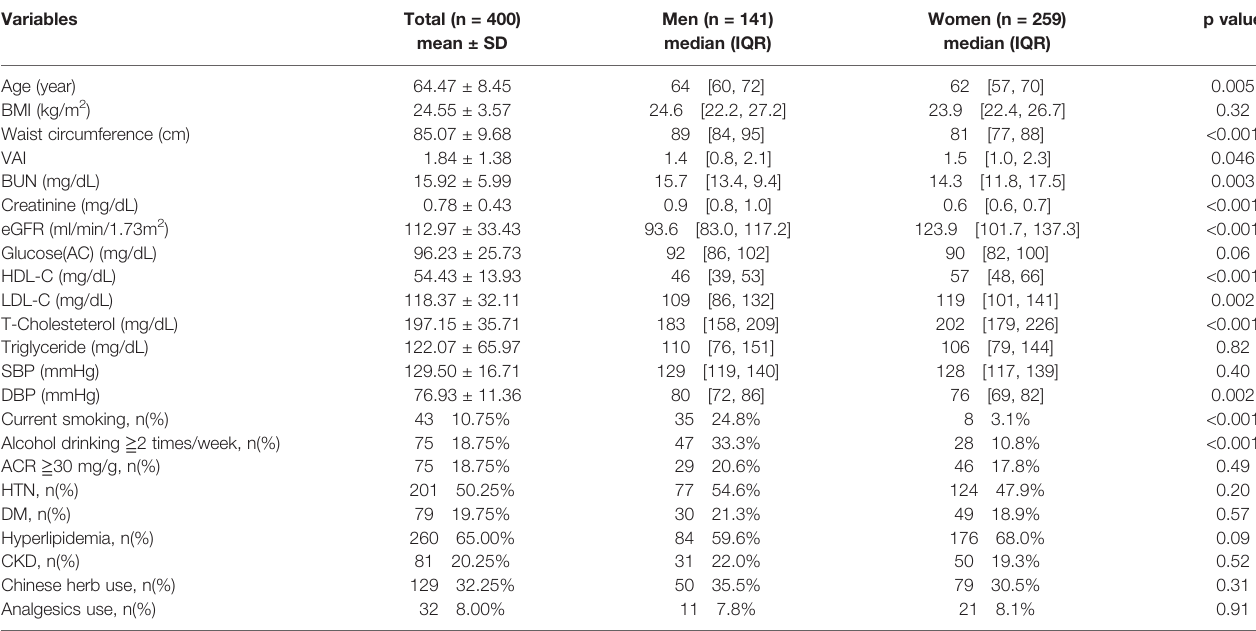
TABLE 1 | General characteristics of the study population according to gender.